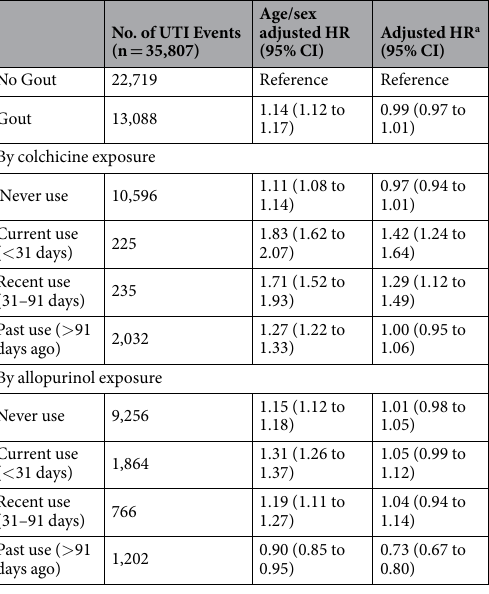
Reference Reference